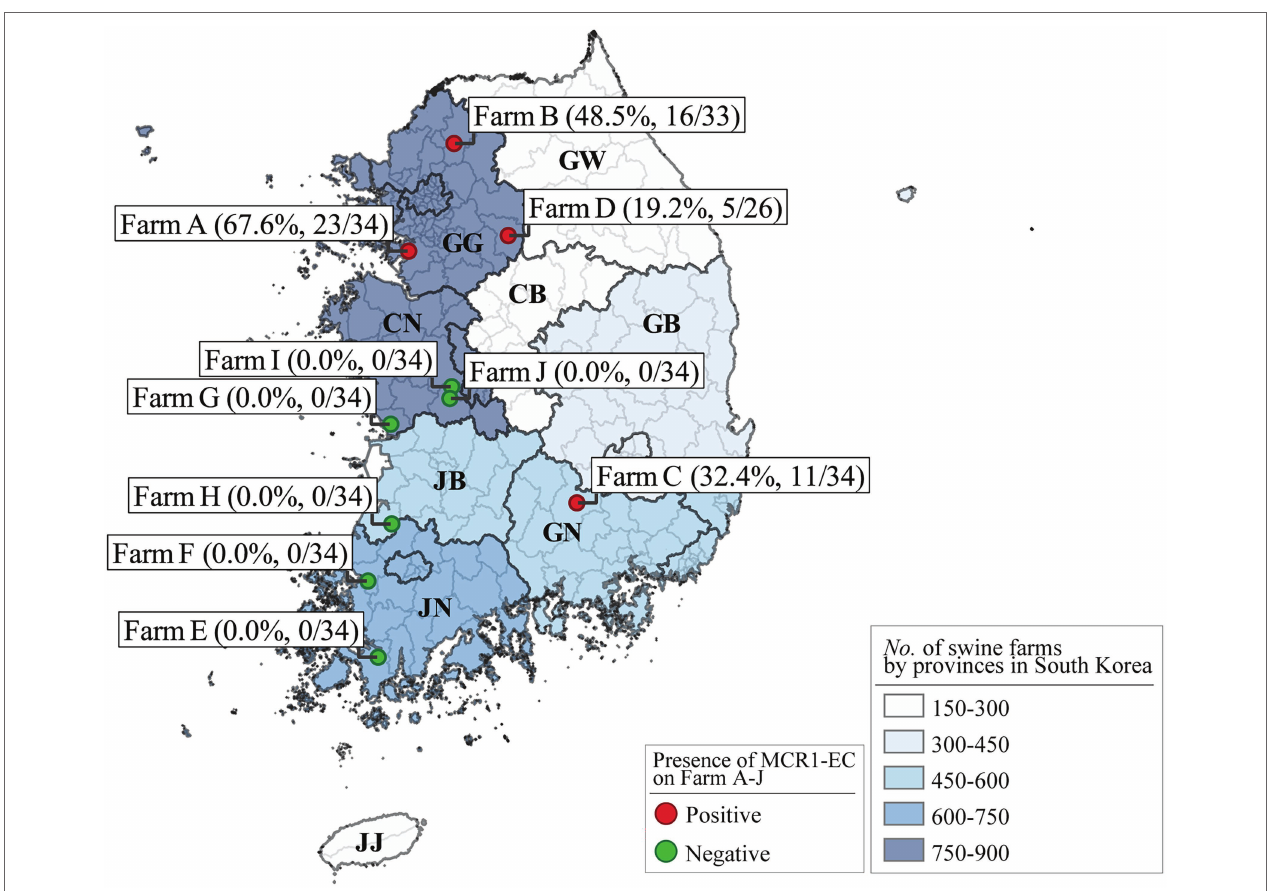
FIGURE 2 | Escherichia coli strains carrying mcr-1 (MCR1-EC) prevalence in Farms A–J and number of swine farms by South Korean province. The numbers in parentheses show the unweighted prevalence of MCR1-EC and the number of MCR1-EC-positive samples versus that of total samples for each farm. The number of pig farms by province in South Korea was obtained from the 2017 demographic report of the Korean Statistical Information Service of Statistics Korea. Visualization was conducted using the QGIS geographic information system program (v3.16.15). MCR1-EC, Escherichia coli carrying the mobilized colistin resistance gene mcr-1.1 ; GG, Gyeonggi-do; CN, Chungcheong-nam-do; JB, Jeolla-buk-do; JN, Jeolla-nam-do; GN, Gyeongsang-nam-do; GB, Gyeongsang-buk- do; CB, Chungcheong-buk-do; and GW, Gangwon-do; JJ,